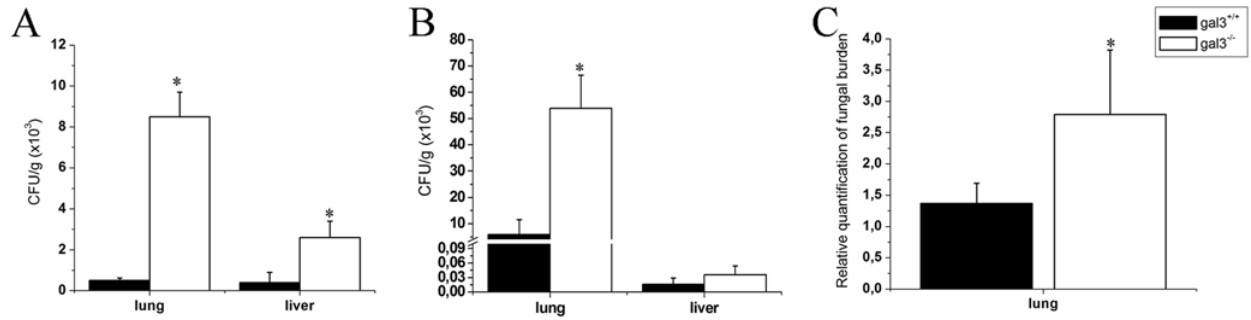
Figure 3. Absence of galectin-3 leads to increased P.brasiliensis burden. Colony-forming units (CFU) recovered from lungs and liver (A) of gal3 + / + (black bars) and gal3 2 / 2 (open bars) mice 30 days after intraperitoneal (A) and intratracheal (B) infection with yeast cells. Relative quantification of P. brasiliensis in the lungs of infected mice 30 days after i.p. infection was carried out through real-time PCR (C). The bars represent the mean 6 SD of CFU obtained from duplicate samples in groups of five animals. * P , 0.05, compared with infected gal3 + / +